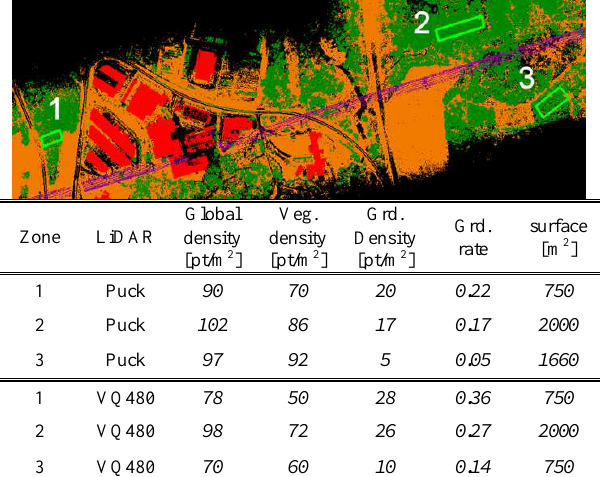
Table 5: density statistics for 3 forested area for Puck and VQ480 LiDAR.